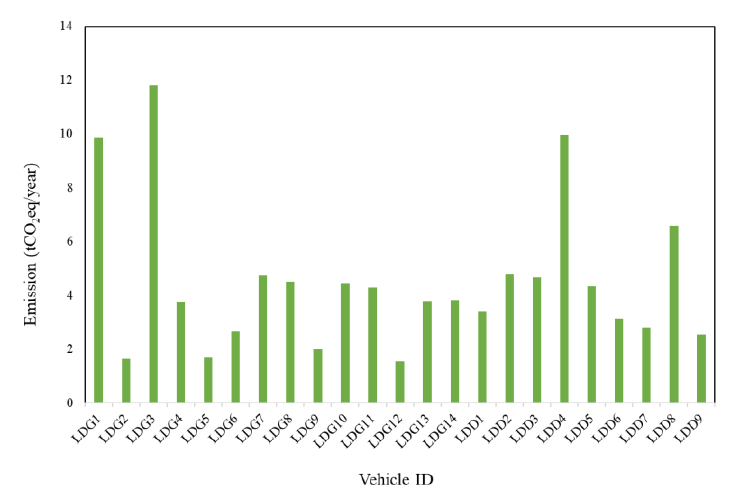
Figure 6. The GHG emissions (tCO 2 eq/year) from LDVs.